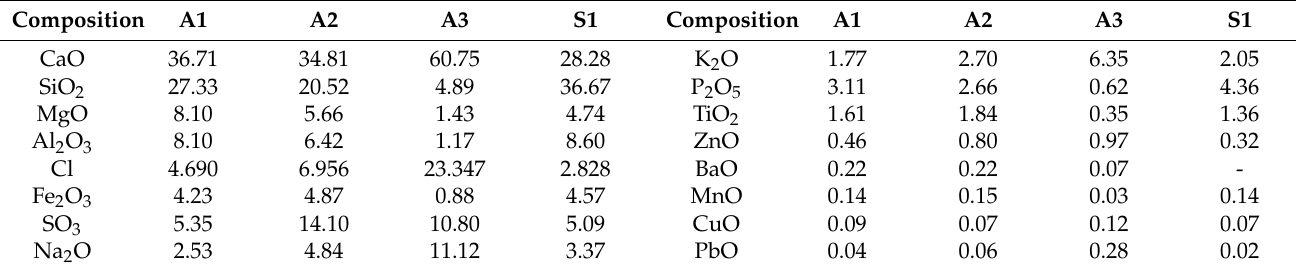
Table 2. Main composition of MSW incineration ash and slag